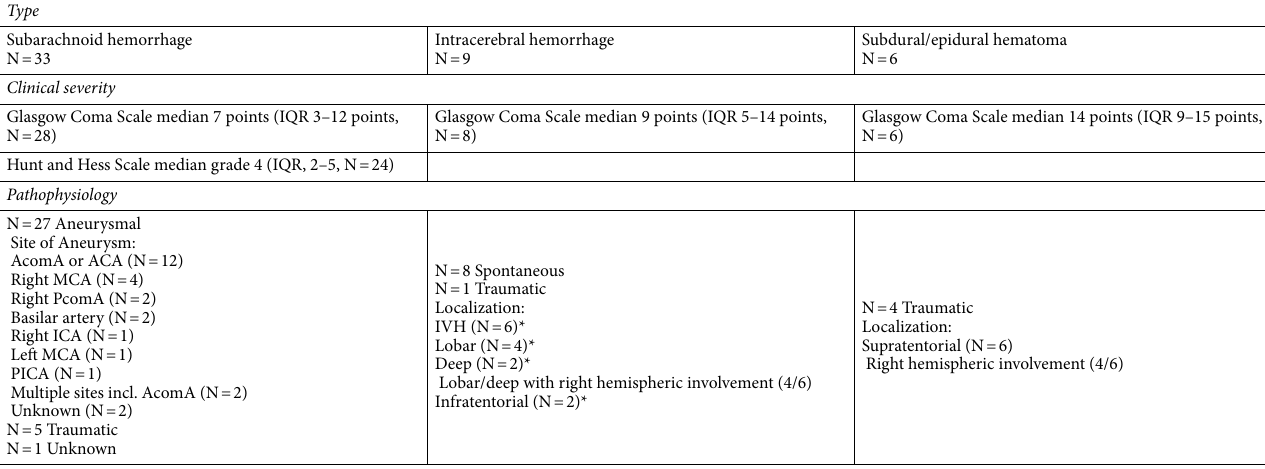
Table 3. Classification of intracranial hemorrhage according to type, clinical severity, and pathophysiology. ACA Anterior cerebral artery, AcomA Anterior communicating artery, ICA Internal carotid artery, IQR Interquartile range, IVH Intraventricular hemorrhage, MCA Middle cerebral artery, PcomA Posterior communicating artery, PICA Posterior inferior cerebellar artery. *Data on localization were available in 8 patients.